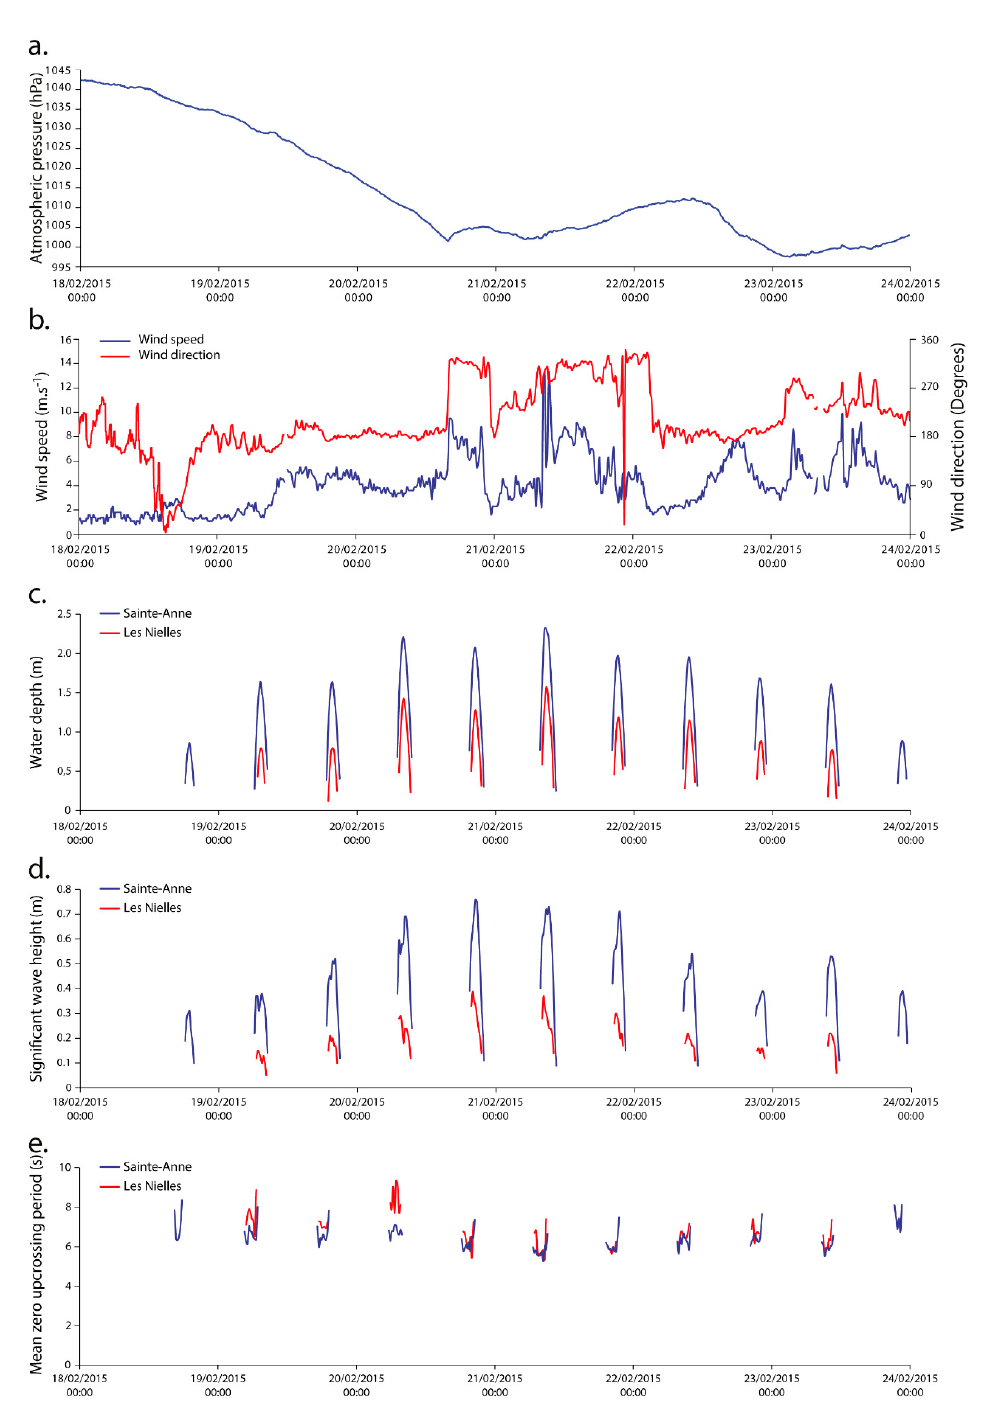
Figure 5. Synthesis of hydrodynamics data during Experiment 1, February 2015 ( a ) atmospheric pressure data, ( b ) wind data, ( c ) water depth data, ( d ) significant wave height data, ( e ) mean zero upcrossing period data.